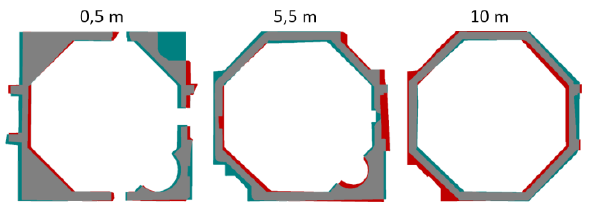
Figure 12. “Horizontal” comparisons between the two models The 3D comparison performed overlapping the models,